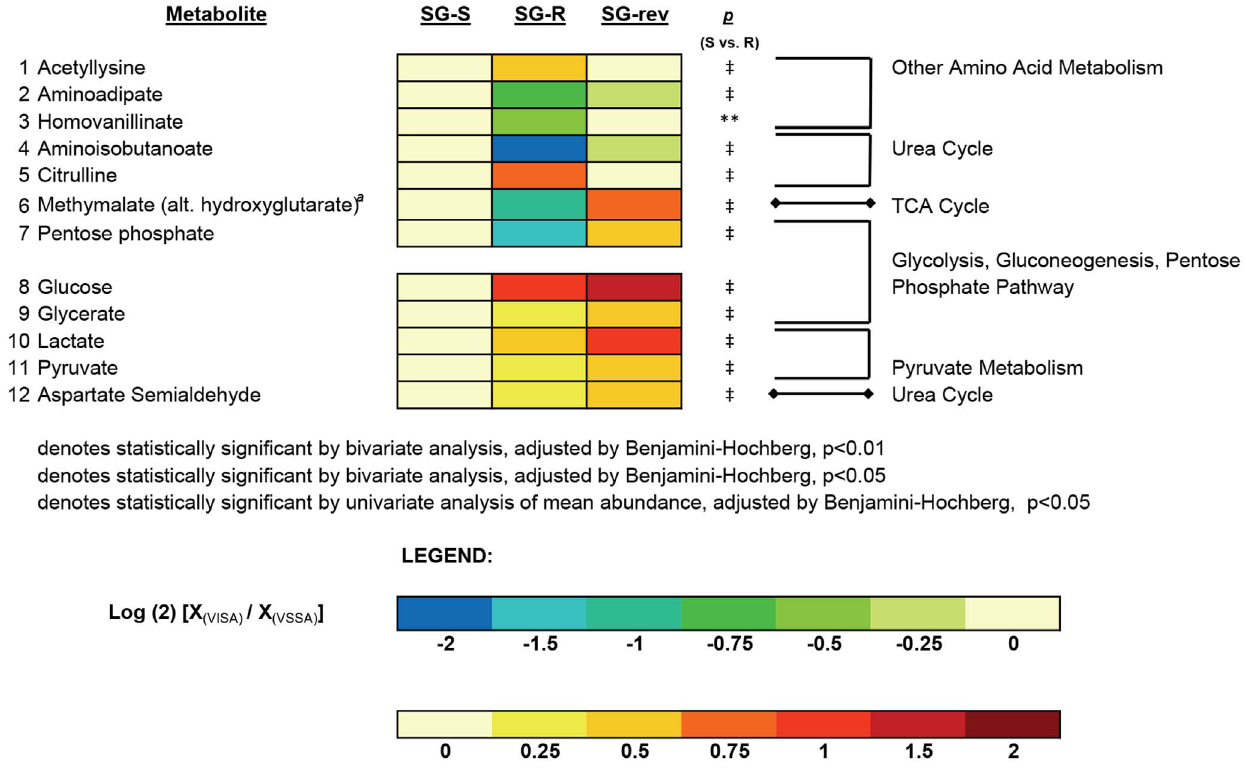
Figure 4. Heat Map of Altered Metabolites in the VISA, SG-R, Versus its Parent VSSA, SG-R and the revertant VSSA, SG-rev. Heat map displaying the 12 metabolites whose abundance was significantly altered in the VISA isolate, SG-R compared against the parent VSSA, SG-S. Changes in abundance are indicated by color coding with red indicative of increases in mean intracellular abundance relative to the baseline (defined by the abundance in SG-S) and blue indicative of decreases in intracellular abundance on a log (2) scale. Specific p -values for the comparison of SG-R versus SG-S are denoted to the near right of the heat map. Metabolites are grouped according to pathway, denoted to the far right of each metabolite. Metabolites 1–7 reversed directionality in the revertant isolate (SG-rev) indicating a link to vancomycin resistance. Metabolites 8–12, however, did not reverse in SG-rev and are separated by a row to denote this difference. The superscript ( a ) denotes unable to determine if methylmalate or hydroxyglutarate in the absence of a chemical standard.